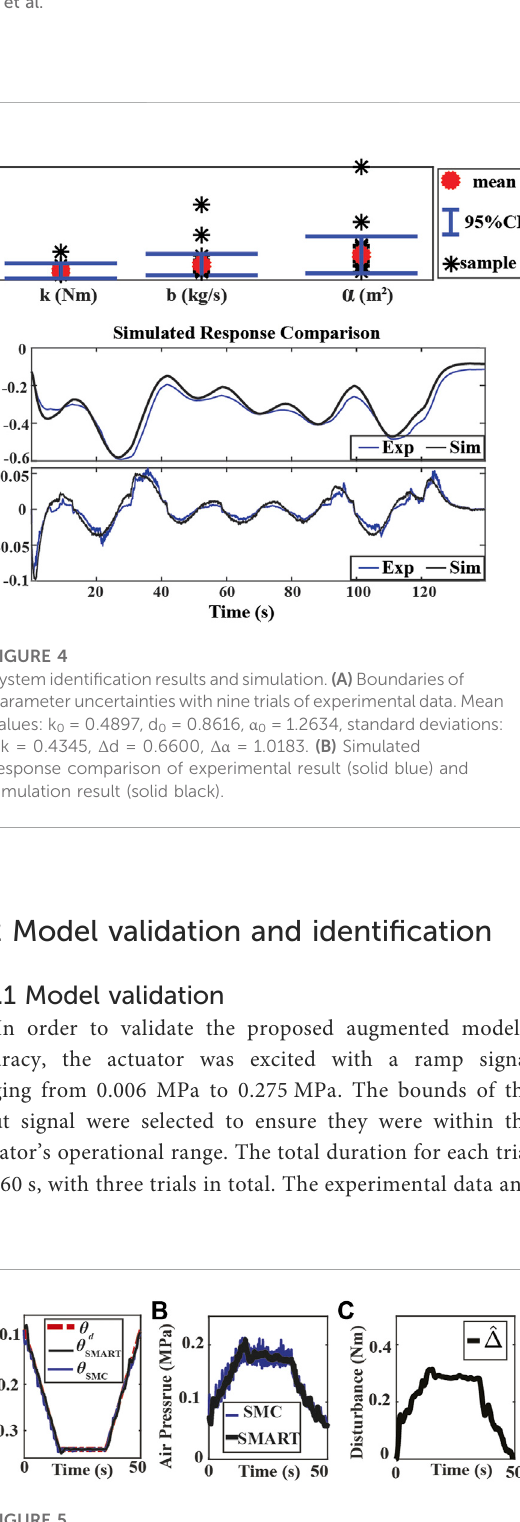
FIGURE 5 Experiment results of bending angle tracking without an obstacle. (A) Tracking results using the SMART and SMC approaches where θ d , θ SMART and θ SMC are the desired (dash- dotted red) and the measured bending angles of SMART approach (solid black) and SMC approach (solid blue). (B) Measured chamber pressures from SMC (solid blue) and SMART (solid black) controller experiments. (C) Estimated lumped